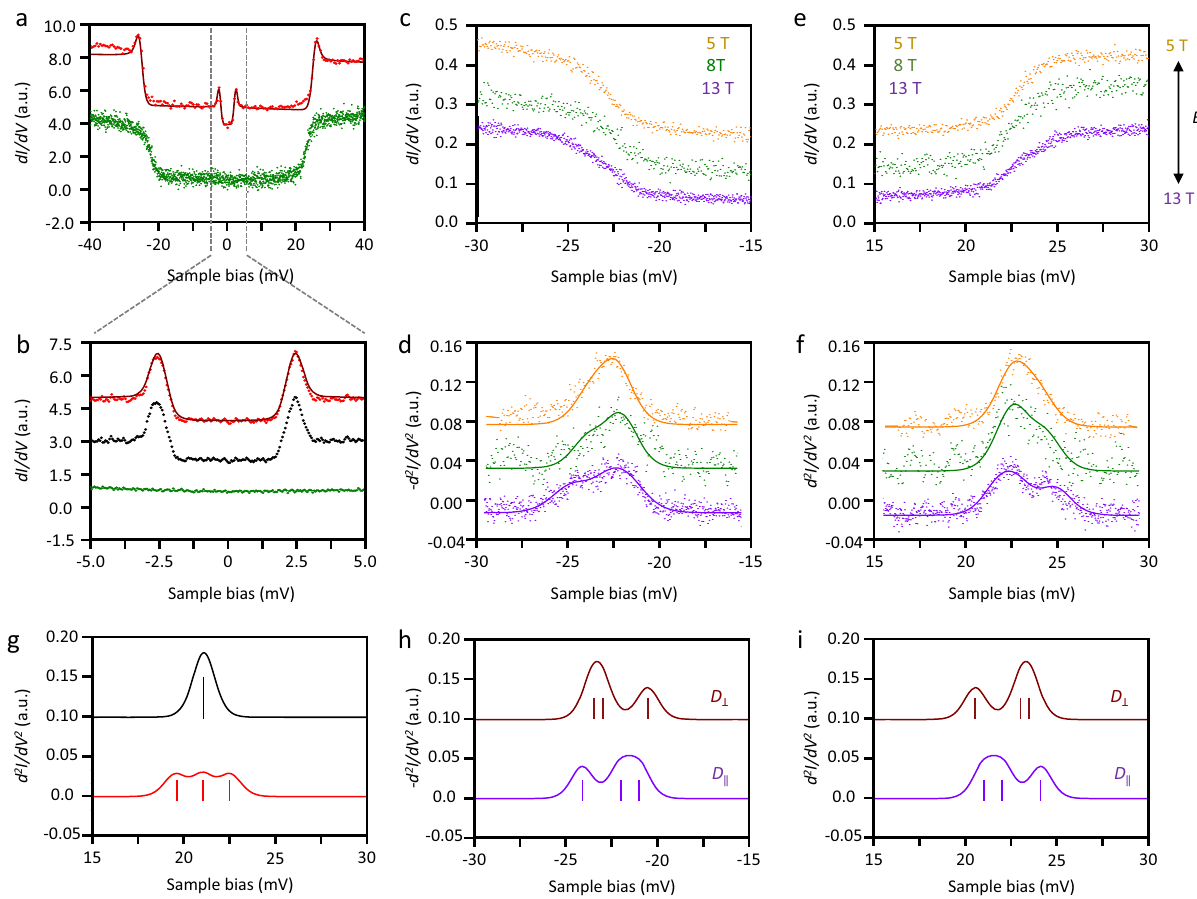
Fig. 3 The singlet – triplet transition in a Cobalt phthalocyanine molecule with vertical σ v mirror plane symmetry (CoPc v ). a Differential conductance (d I / d V ) spectra measured on CoPc v at B = 0 (red dots) and at B = 8 T, where superconductivity is suppressed (green dots). Here, B is the magnetic fi eld perpendicular to the sample surface. The full line at B = 0 is a least-square fi t to a model, which accounts for the superconducting gaps in tip and sample and the spin excitation. b Detail of the curves in a (red and green dots) and spectrum measured on the bare NbSe 2 surface (black dots), showing that neither Yu-Shiba-Rusinov states nor a Kondo peak can be detected on the molecule ( V = − 5 mV, I = 50 pA). Here, V is the bias voltage, and I is the tunneling current. The dark red line is a fi t to a superconducting tunneling model. c – f d I /d V and numerically derived d 2 I / dV 2 spectra measured on CoPc v at B = 5, 8 and 13 T, respectively. Full lines in ( d , f ) are least-square fi ts to a perturbative transport model. The spectra reveal an asymmetric splitting of the inelastic excitation at ≈ ±23 mV in fi eld. g Expected splitting of a triplet excitation at B = 13 T (red line) if only Heisenberg exchange interaction between both spins is taken into account. h , i Accounting for an additional non-collinear Dzyaloshinskii – Moriya (DM) interaction rationalized the observation if the DM vector lies in the surface plane ( D ∣∣ ). A DM vector pointing out of surface ( D ⊥ ) would reverse the intensity order. Curves in all panels are vertically offset for